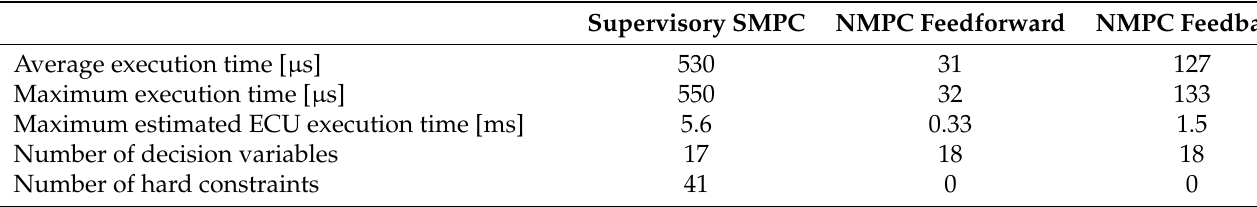
Figure 13. Optimization, solvers, and software implementation platforms used in the literature for implementing MPC for different control applications on compression ignition (CI) and spark ignition (SI) engines. Table 4. Problem size and execution time for MPC controllers reported in [26]—ECU execution times are estimated for a 256 MHz ECU clocking